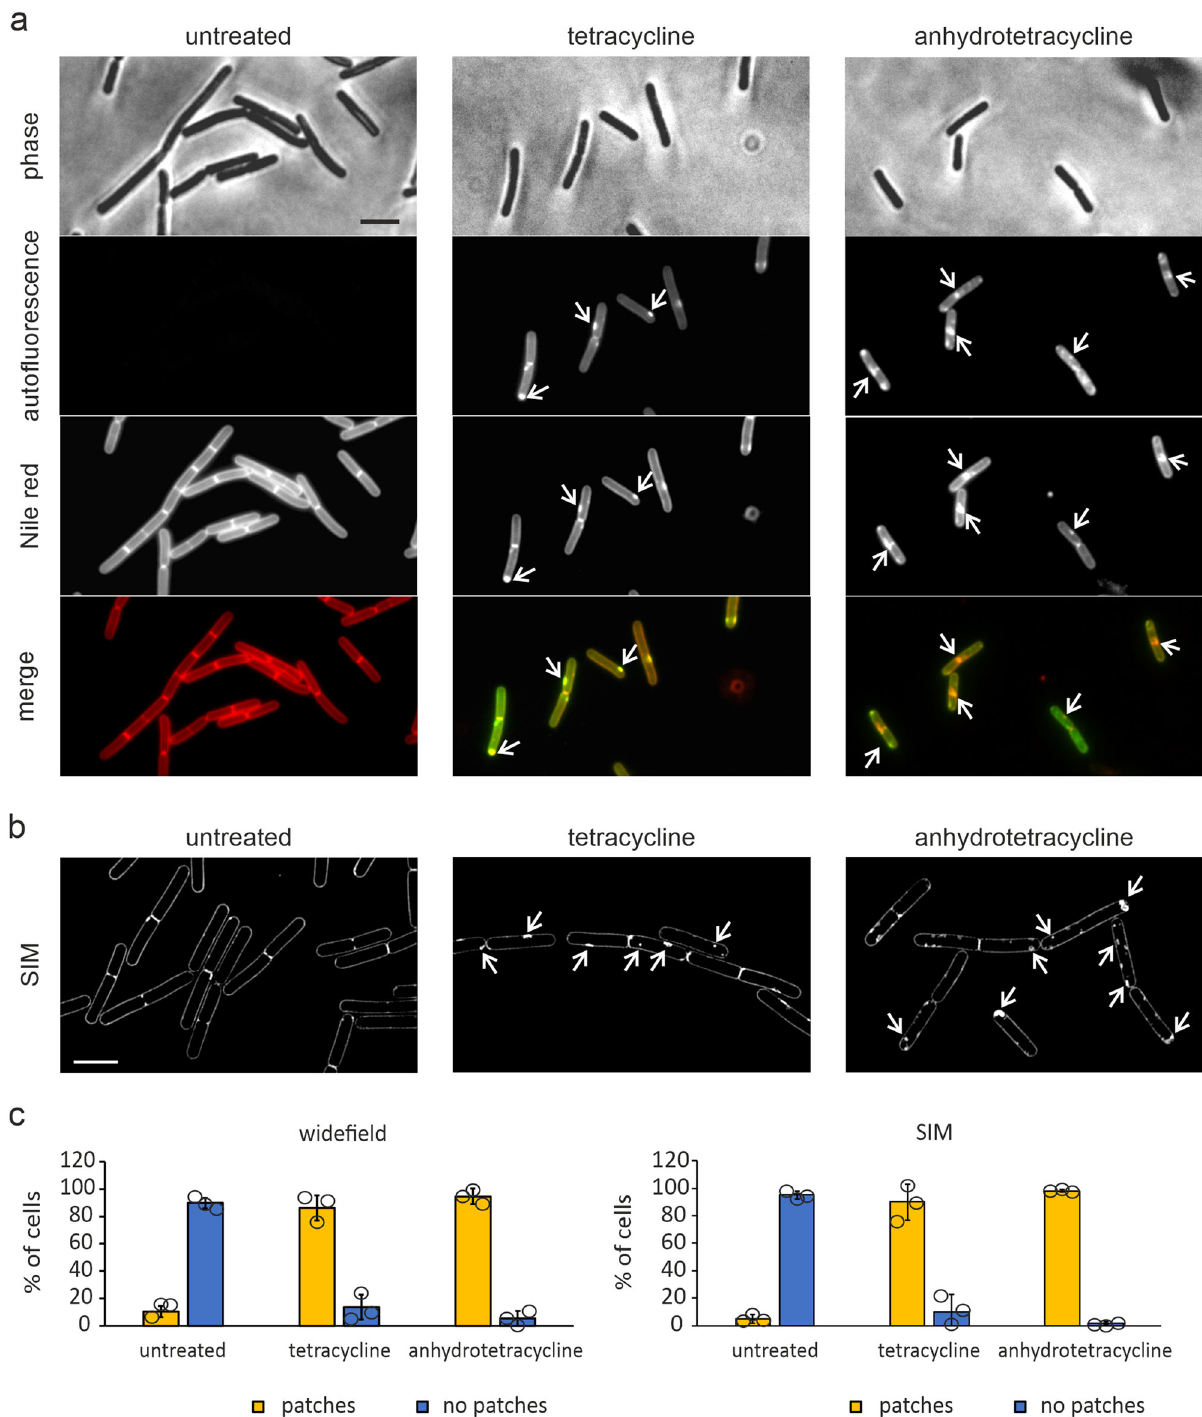
Fig. 4 Tetracycline targets the cytoplasmic membrane. a Fluorescence microscopy images of cells treated with either tetracycline or anhydrotetracycline for 30 min. Both antibiotics display green auto fl uorescence allowing direct localization of the compound. Cell membranes were stained with Nile red. Arrows indicate fl uorescent membrane patches coinciding with accumulation of the respective antibiotic. b SIM microscopy images of cells treated with either tetracycline or anhydrotetracycline for 30 min. Membranes were stained with Nile red. Arrows indicate membrane staples or invaginations. Scale bars 2 µ m. c Quanti fi cation of cells showing membrane patches from wide fi eld ( a ) and SIM ( b ) images. Images were quanti fi ed manually. Sample size was ≥ 100 individual cells per condition for wide fi eld and ≥ 50 individual cells per condition for SIM. Error bars show standard deviation of the mean of three replicate experiments. Circles indicate individual